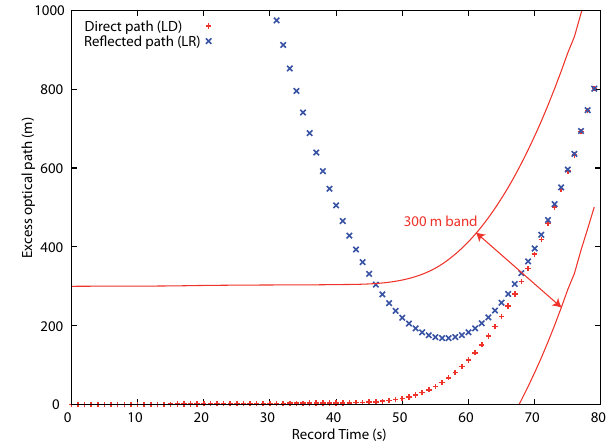
Fig. 3. Direct and reflected excess optical paths (m). The 300m band represents the range of delays when the reflected signal will be captured by the correlator that tracks the direct signal, and interfere with